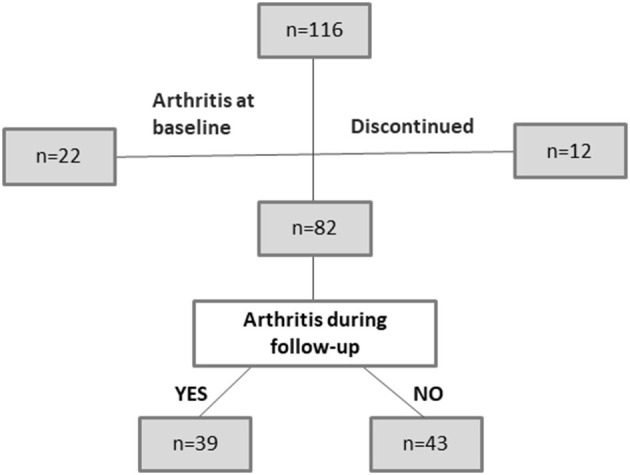
Distribution of patients during the study.